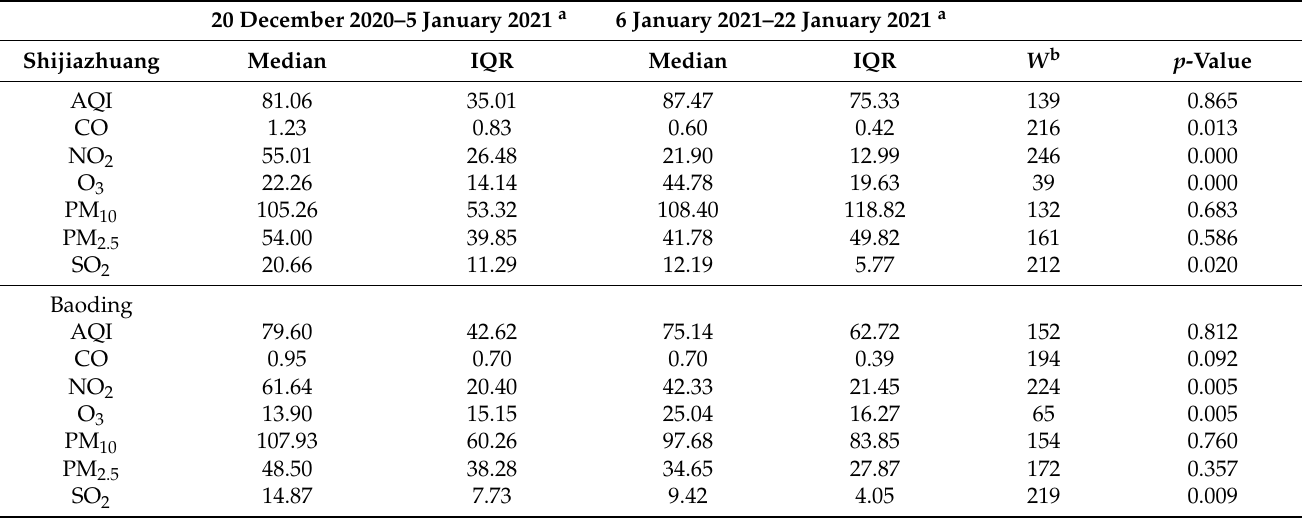
Table 2. Summary statistics of the AQI and pollutants from 20 December 2020 to 22 January 2021.